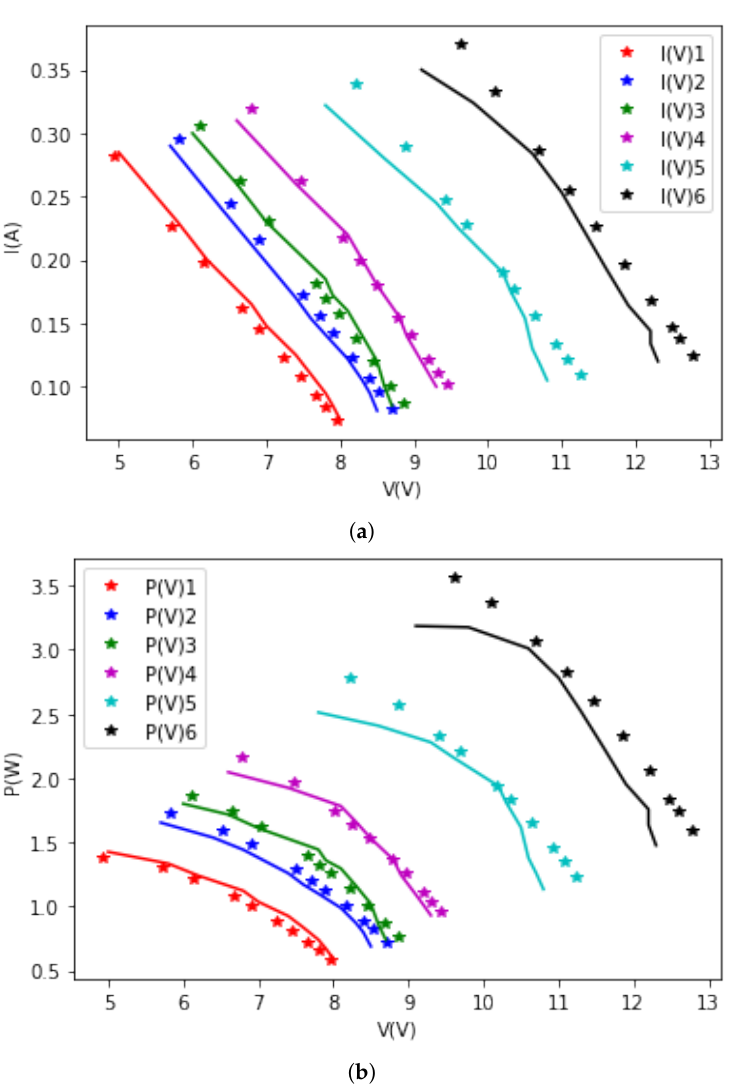
Figure 4. Experimental data for I(V) characteristics (dots) and power P(V) (dots) and fitted data (lines of same colors) for the collector system. Data corresponds to Table 1 in the order: ( a ) I(V) measurements 1 to 6, ( b ) P(V) measurements 1 to 6.